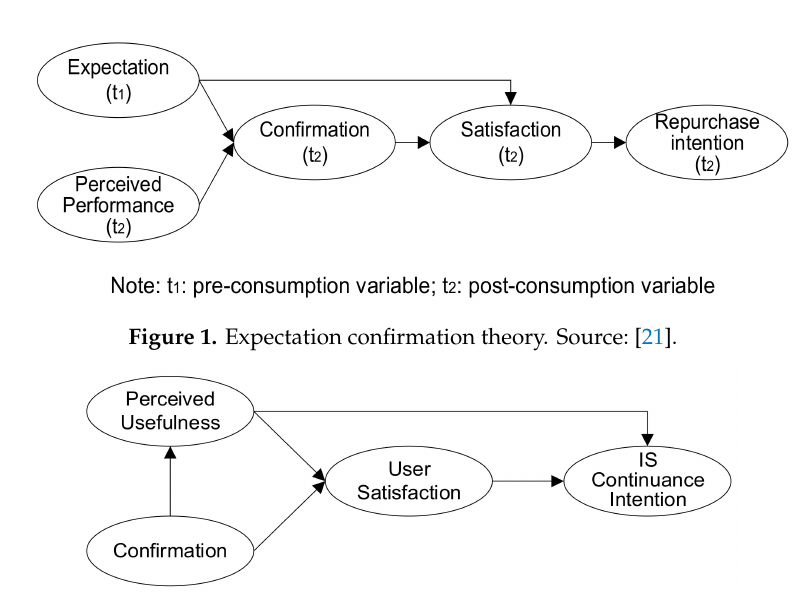
Figure 2. A Post-Acceptance Model of IS (information system) Continuance Source: [22].